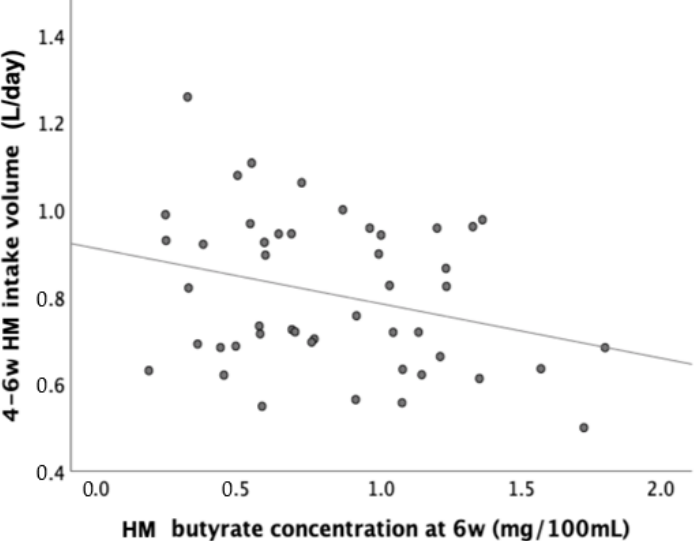
Figure 2. Inverse association between HM butyrate concentration and HM intake volume at 4– 6 weeks ( p = 0.047). HM = human milk, w = weeks.